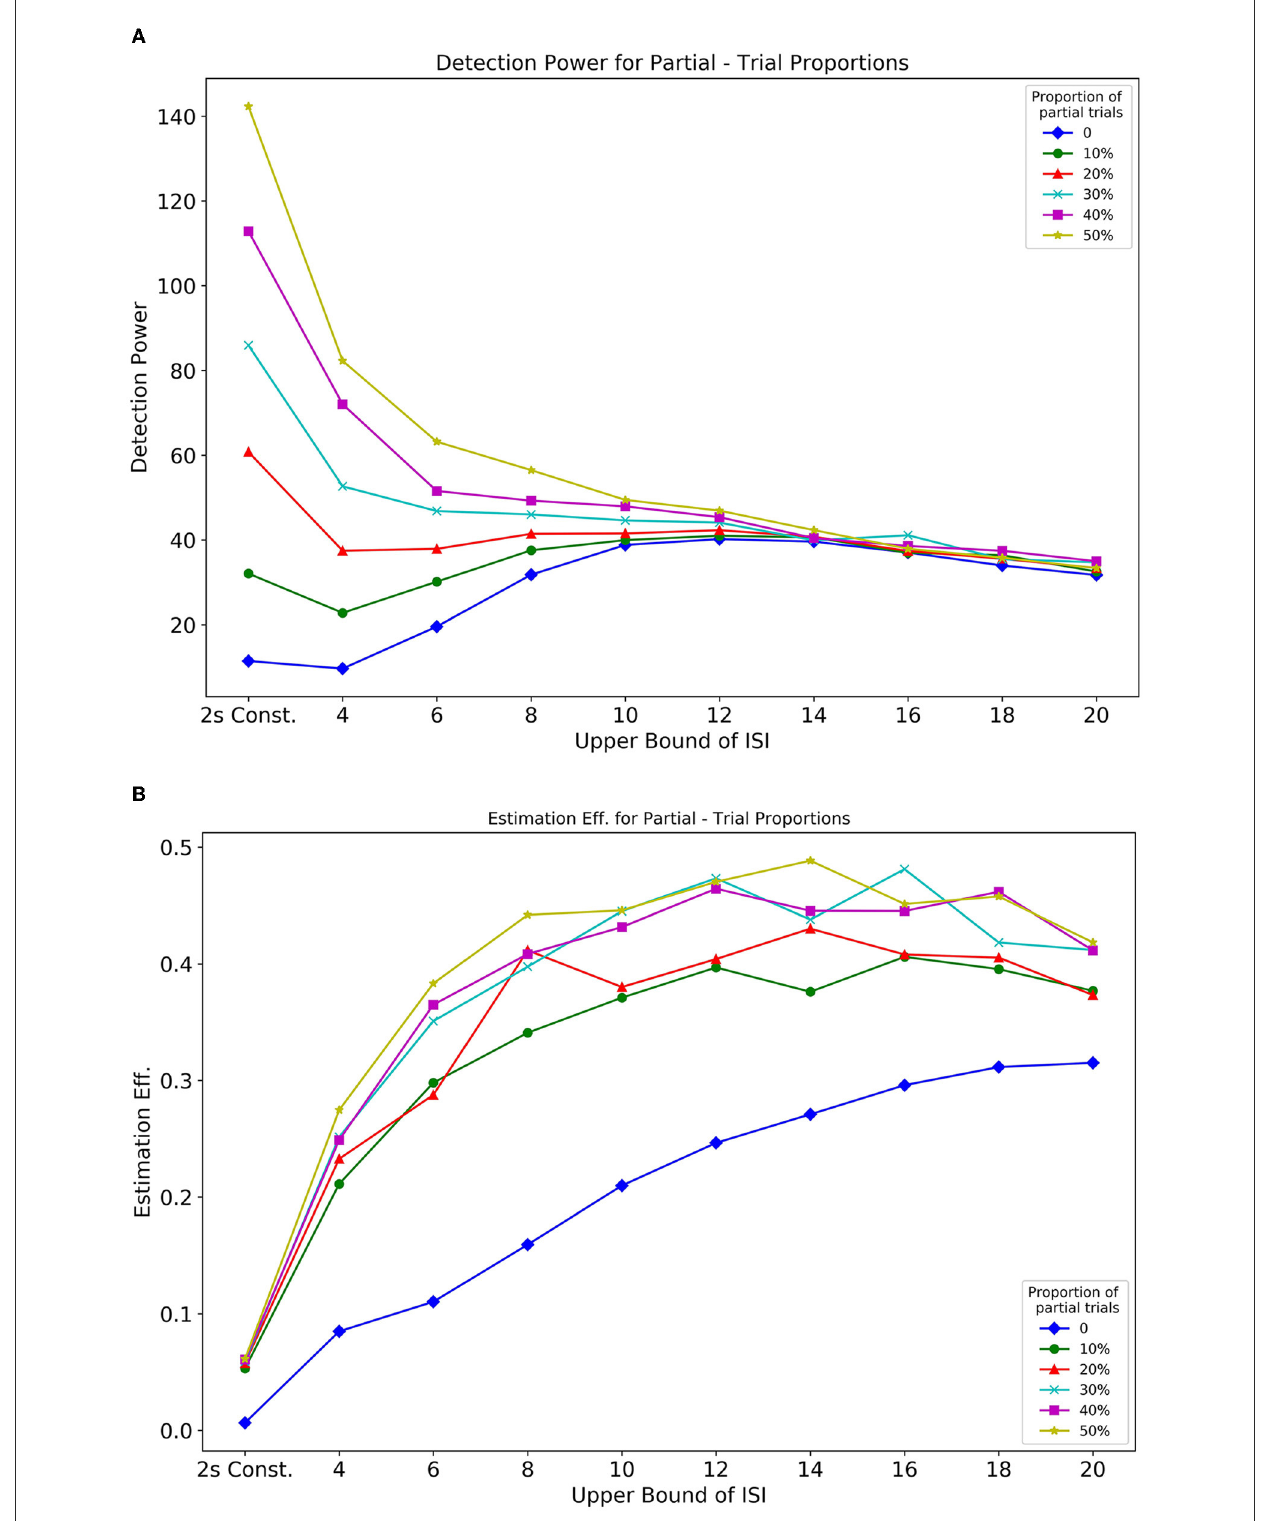
FIGURE10 Optimality measures from Simulation 2 Optimalities are as a function of the proportion of partial trials and ISI. (A) Detection power. (B) Estimation